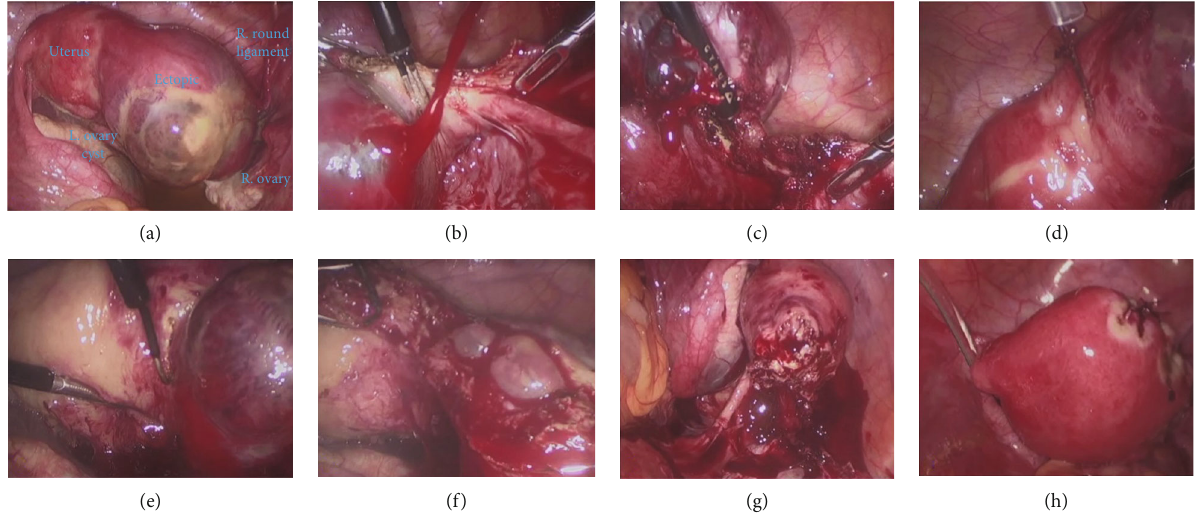
Figure 1: (a) The anatomical relation with other pelvic structures is shown in this panel. (b) Profuse bleeding caused by spontaneous rupture of the ectopic. (c) The superior branches of the right uterine artery were coagulated and transected. (d) Injection of diluted vasopressin in the myometrium, close to the border of the ectopic. (e) The uterine wall is incised with monopolar cautery. (f) The gestational sac is exposed and ruptured during dissection. (g) A portion of the uterine horn has been excised. (h) The uterine wound was closed with interrupted